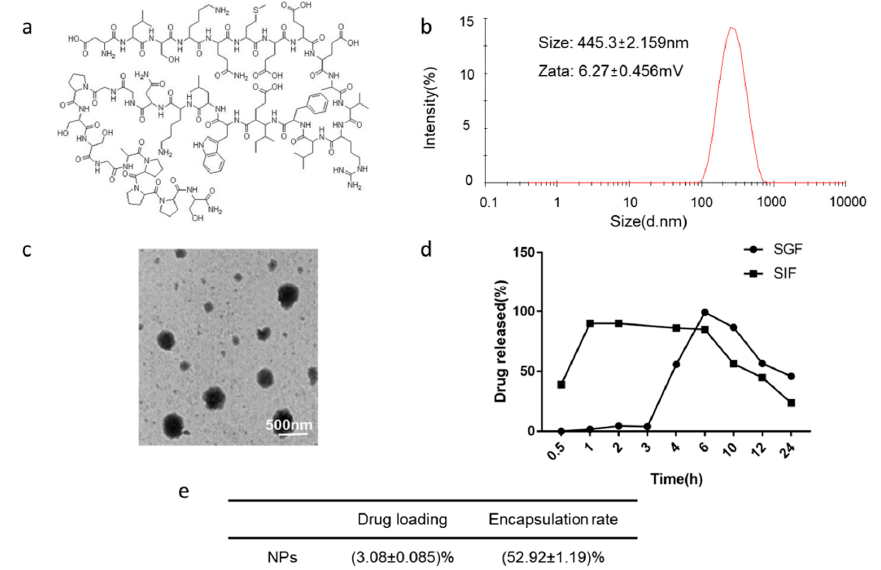
Figure 1. ( a ) The chemical structure of exenatide. ( b ) The size distribution and zeta potential of CS-TPP-ALG. ( c ) TEM image of CS-TPP-ALG. ( d ) In vitro drug release profile of exenatide nano-preparation. ( e ) Encapsulation rate and drug loading capacity of exenatide nanoparticles.